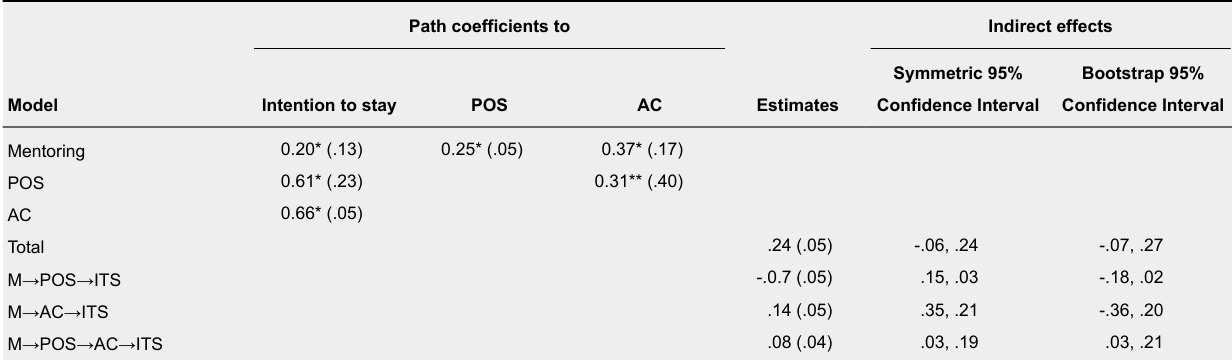
Path Coefficients and Indirect Effects for Mediation